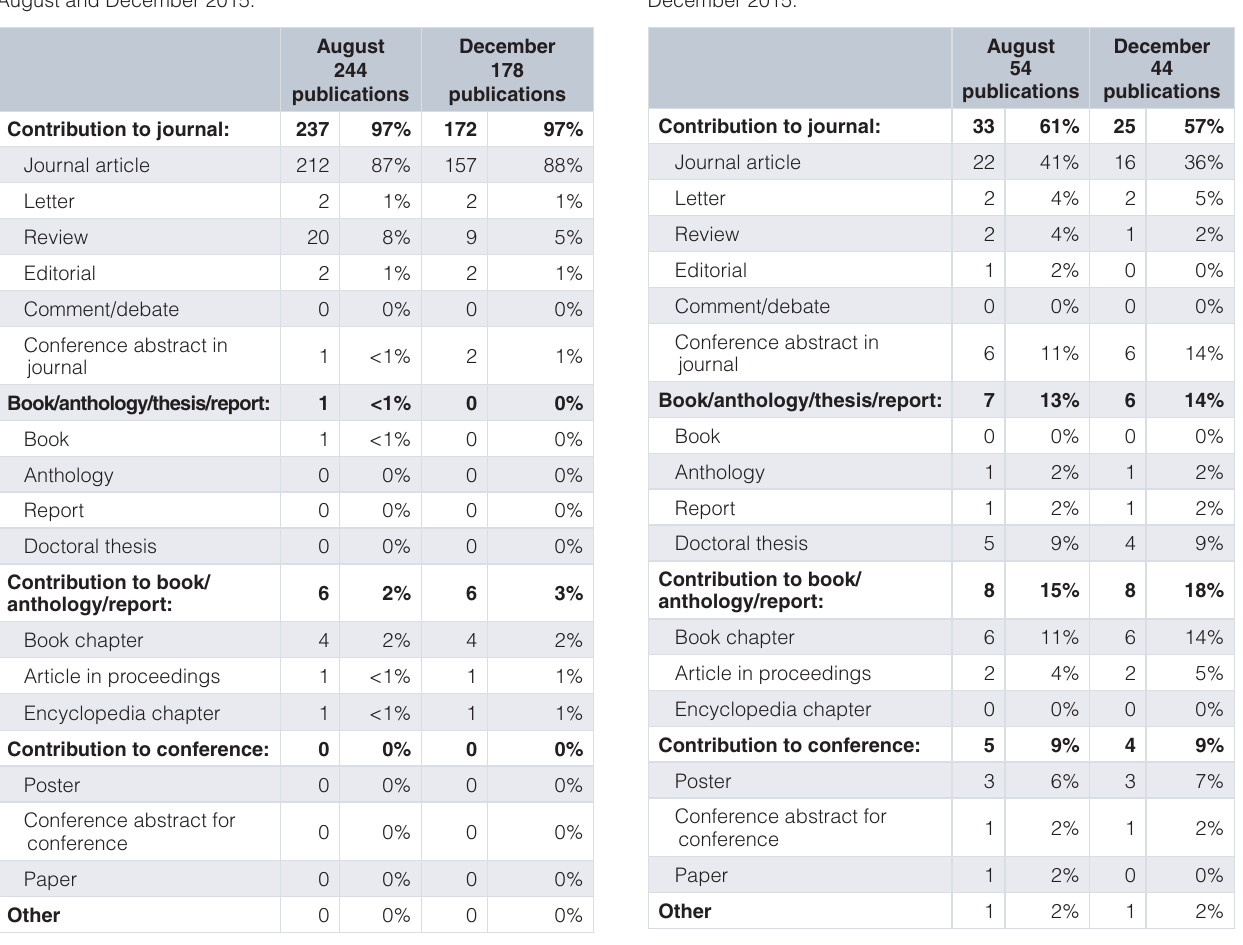
Table 5c. Publication type in Pure of publications without UID not exported from Pure to SciVal. Download from August and